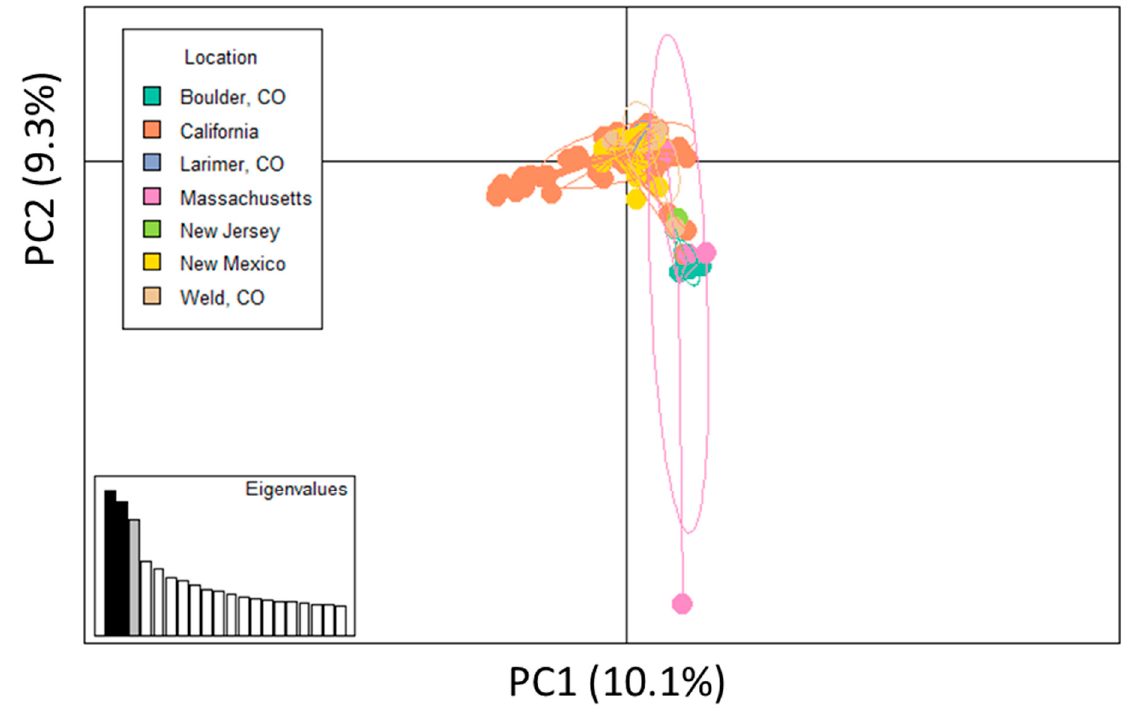
Figure 4. Evidence of separation based on clinic location for Boulder, Massachusetts, and part of California. Principal component analysis (PCA) plot for microsatellite regions, with samples colored according to clinic. One sample from Massachusetts was an outlier. The portion of California samples that appear distinct were collected in the same month. Locations included in study are California; New Mexico; Boulder County, CO; Larimer County, CO; Weld County, CO; New Jersey; and Massachusetts.